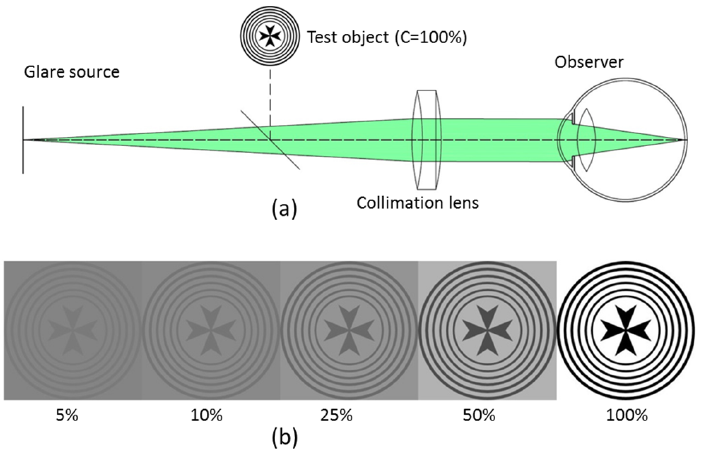
Table 1. Maximum glare angle and illuminance entering the pupil of the eye.